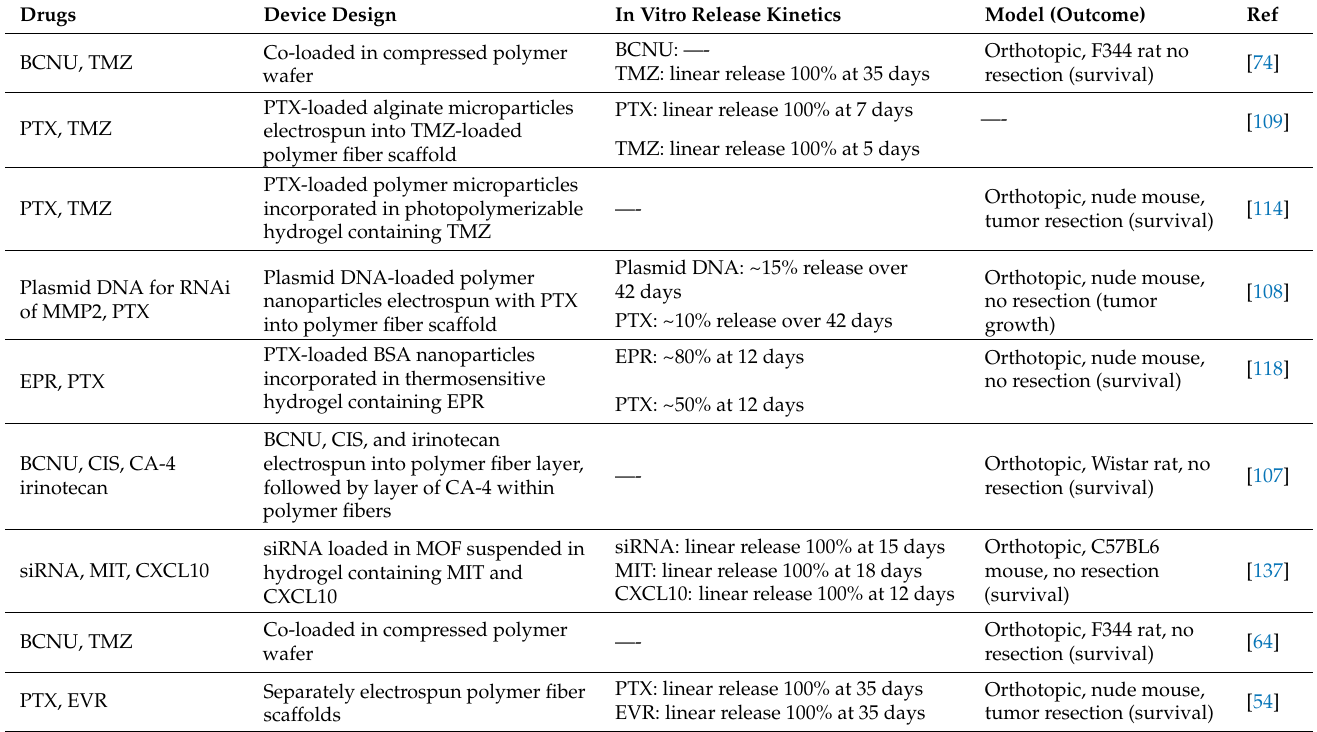
Key terms: BCNU: carmustine; BSA: bovine serum albumin; CA-4: combretastatin; CIS: cisplatin; CXCL10: C-X-C Motif Chemokine Ligand 10; EPR: epirubicin; EVR: everolimus; MIT: mitoxantrone; MMP2: matrix metalloproteinase-2; PTX: paclitaxel; RNAi: interfering RNA; TMZ: